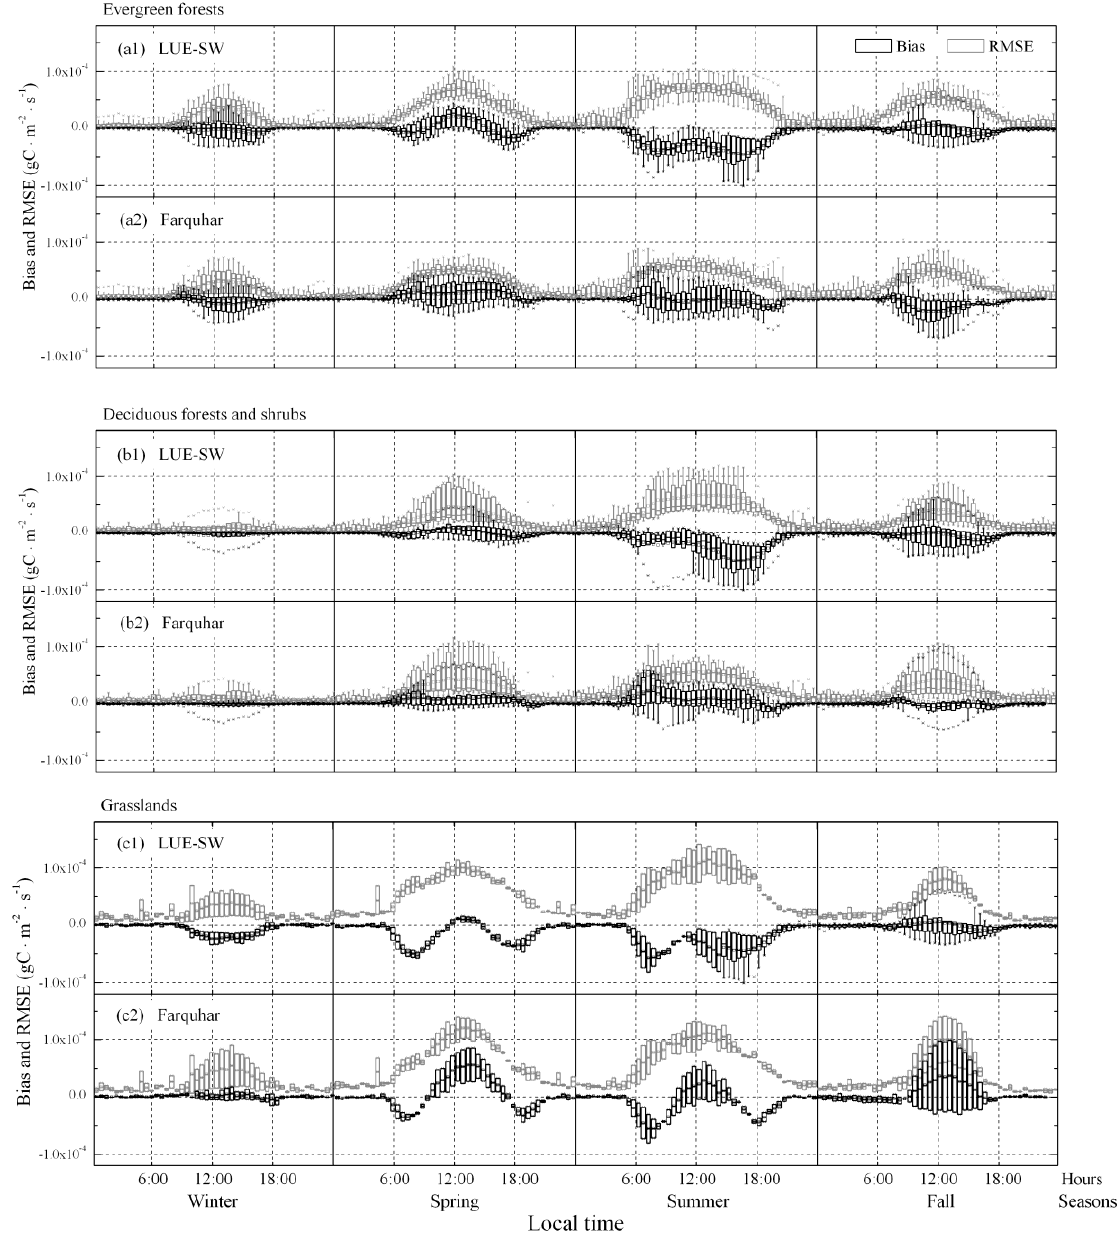
Figure 4. Boxplots of bias and root-mean-square error (RMSE) for seasonally averaged diurnal composites simulated by the LUE-SW and the Farquhar model: ( a ) evergreen forests; ( b ) deciduous forests and shrubs; and ( c )